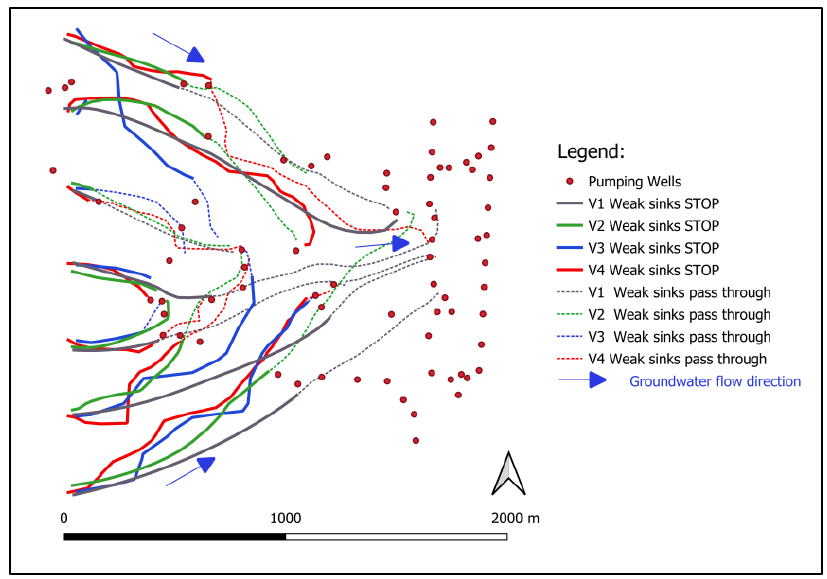
Figure 14. Groundwater pathlines prediction of individual model variants with the stop and pass- through weak sinks setting in the MODPATH 6 software .